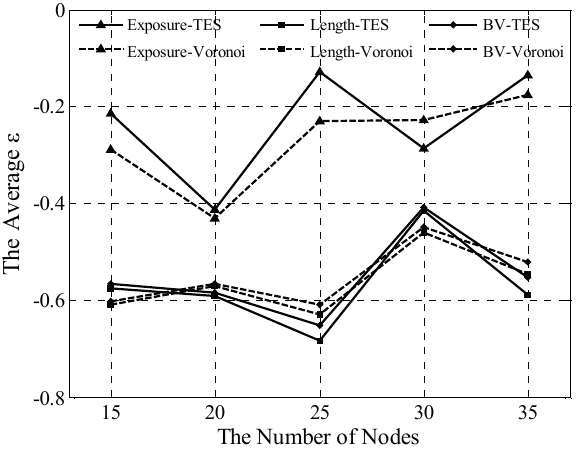
Figure 9. Averaged ε analyses for homogeneous